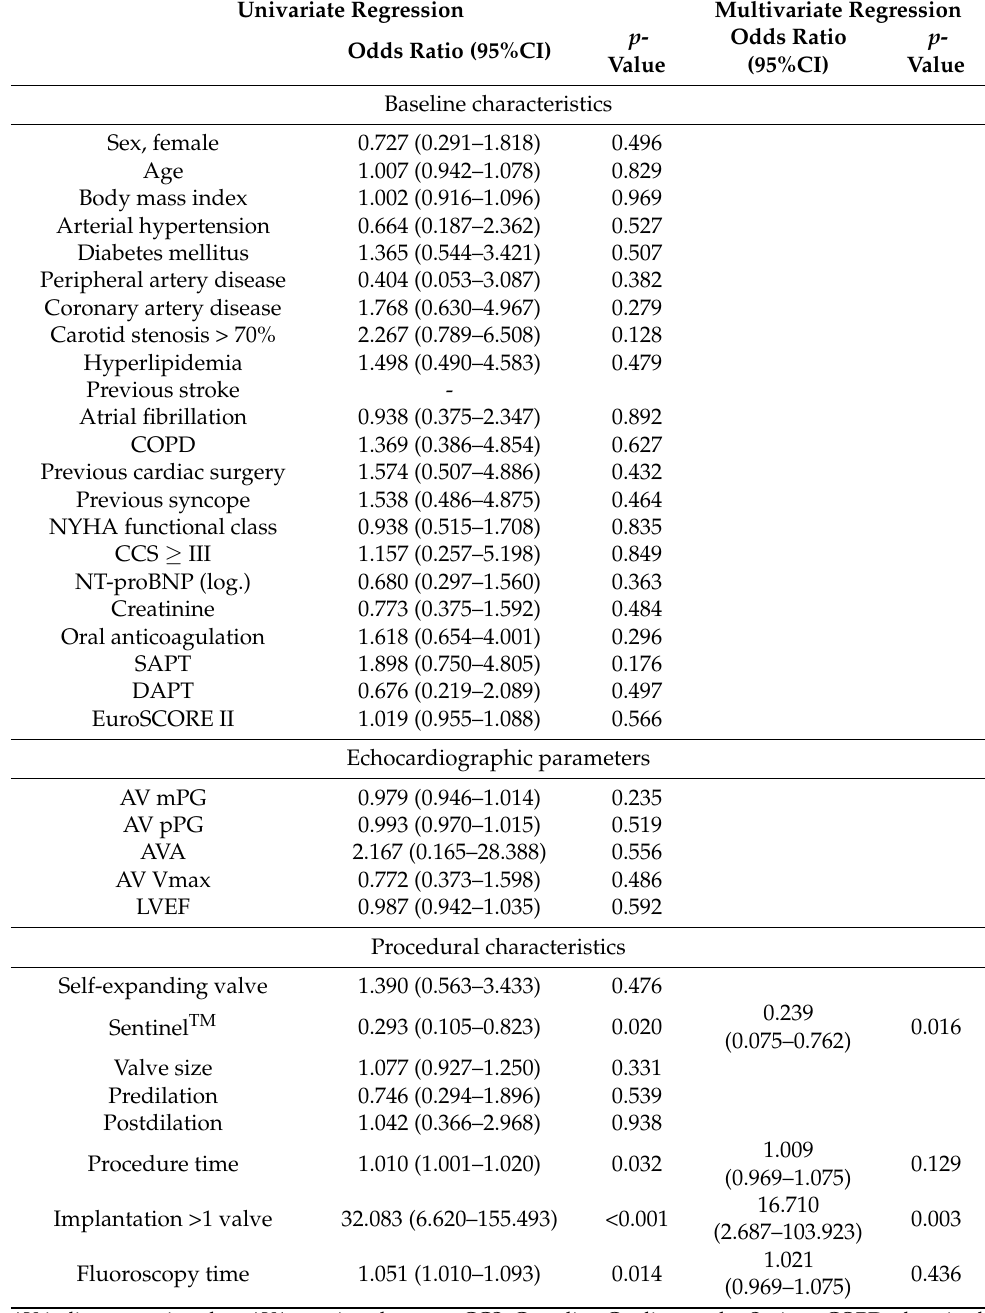
Table 3. Logistic regression analysis - Cerebrovascular events at 72